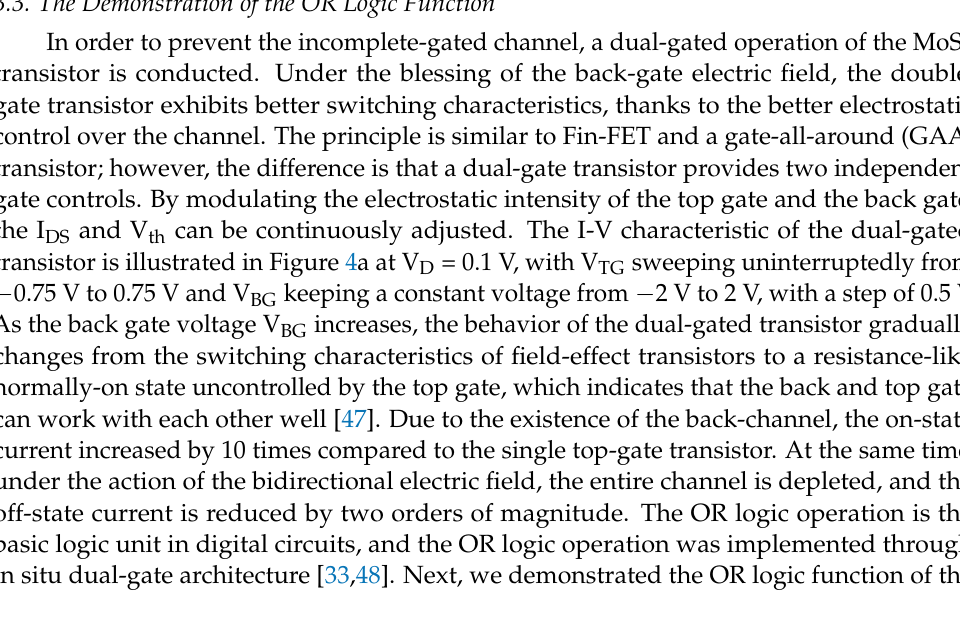
Figure 3. ( a ) The dual-direction transfer characteristic of CIPS/MoS 2 NC-FET with 9.7 nm, 14.8 nm and 21.3 nm CIPS. ( b ) The gate leakage current of CIPS/MoS 2 NC-FET with 9.7 nm, 14.8 nm and 21.3 nm CIPS. ( c ) The output characteristic of vdW NC-FET with a CIPS of 14.8 nm. ( d,e ) The subthreshold swing as functions of log(I DS ) under forward sweep and negative sweep, respectively. ( f ) The subthreshold swing distribution of vdW NC-FET with a CIPS of 14.8 nm under dual-direction sweeping.